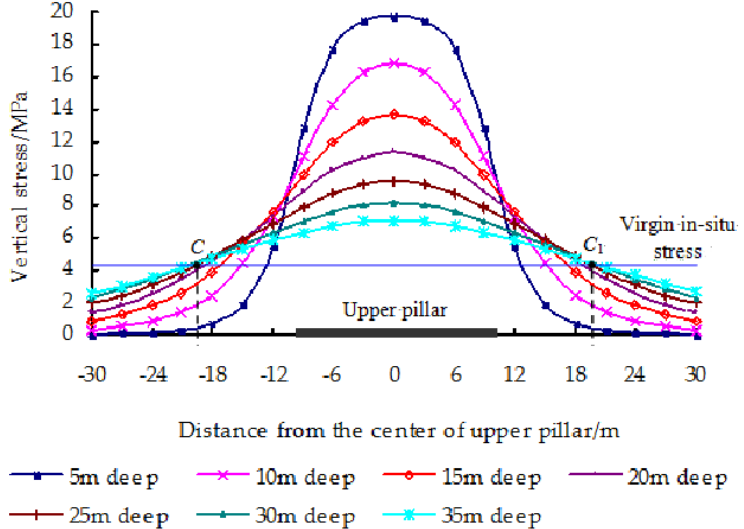
Figure 19. Distribution characteristics of vertical stress vs. different floor depth.